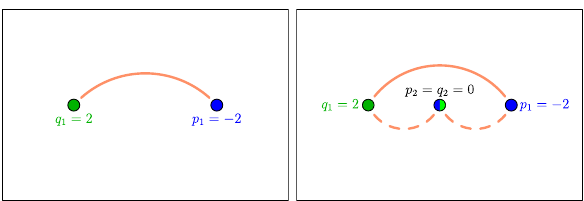
Fig. 1 Distances between two sets s , s (cid:6) , each of which contains one particle (left panel) or two particles (right panel). Blue dots represent particles in set s , green dots stand for particles in set s (cid:6) . The possible pairings used in the distance calculation are indicated by lines. The square norm d 2 erroneously results in a shorter distance for the pairing indicated by the dashed line